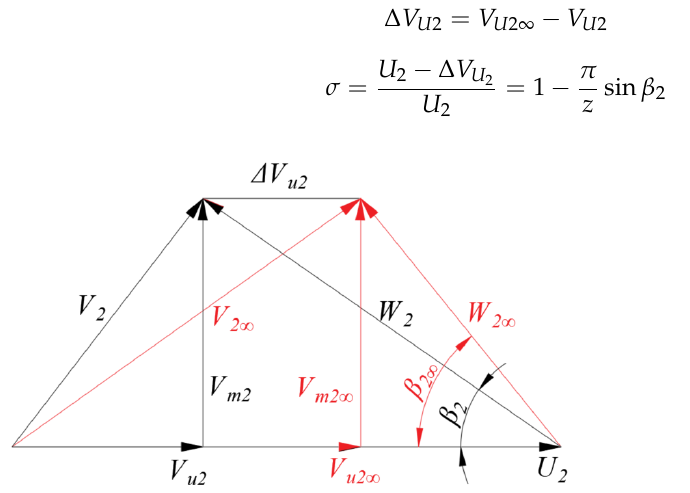
Figure 12. velocity triangle at outlet.